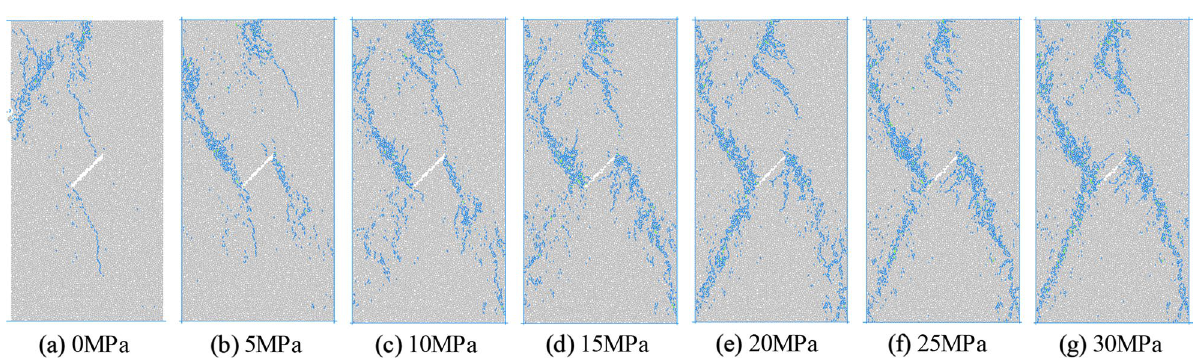
Figure 10. Failure mode of concrete under eccentric